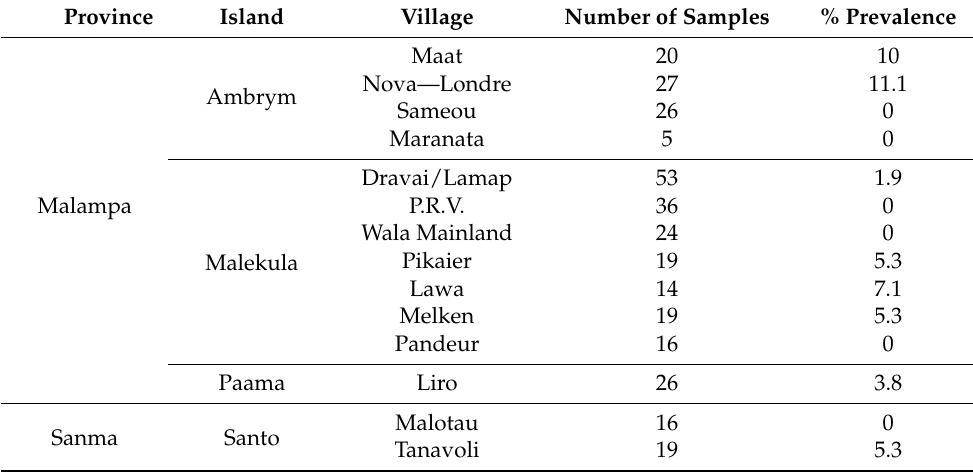
Table 1. 2005 TAS (Transmission Assessment Survey)1/C survey sites, number of samples taken from children aged up to 10 years of age and the prevalence of Bm14 antibody as determined based on cut-off 1 (original